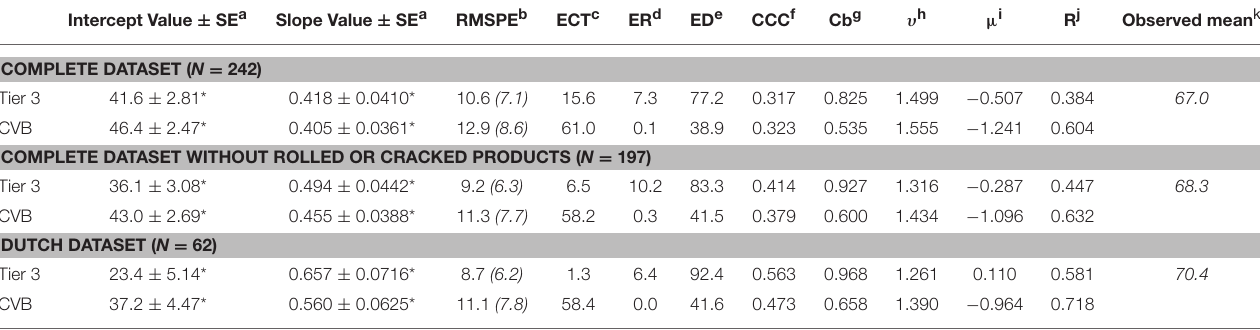
TABLE 5 | Relationship between observed apparent fecal N digestibility (%) and predicted apparent fecal N digestibility (%) with the Tier 3 model and the CVB model (values and calculations based on studies with wethers fed on maintenance level) for the complete dataset, the complete dataset excluding rolled or cracked high moisture maize silage, and the Dutch dataset.